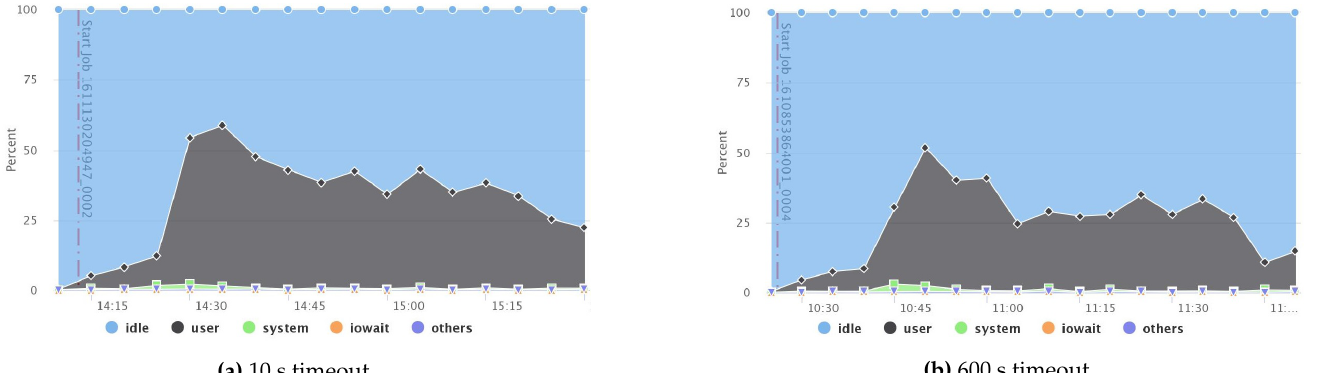
Figure 10. Comparison between CPU usage when using small and default timeouts.